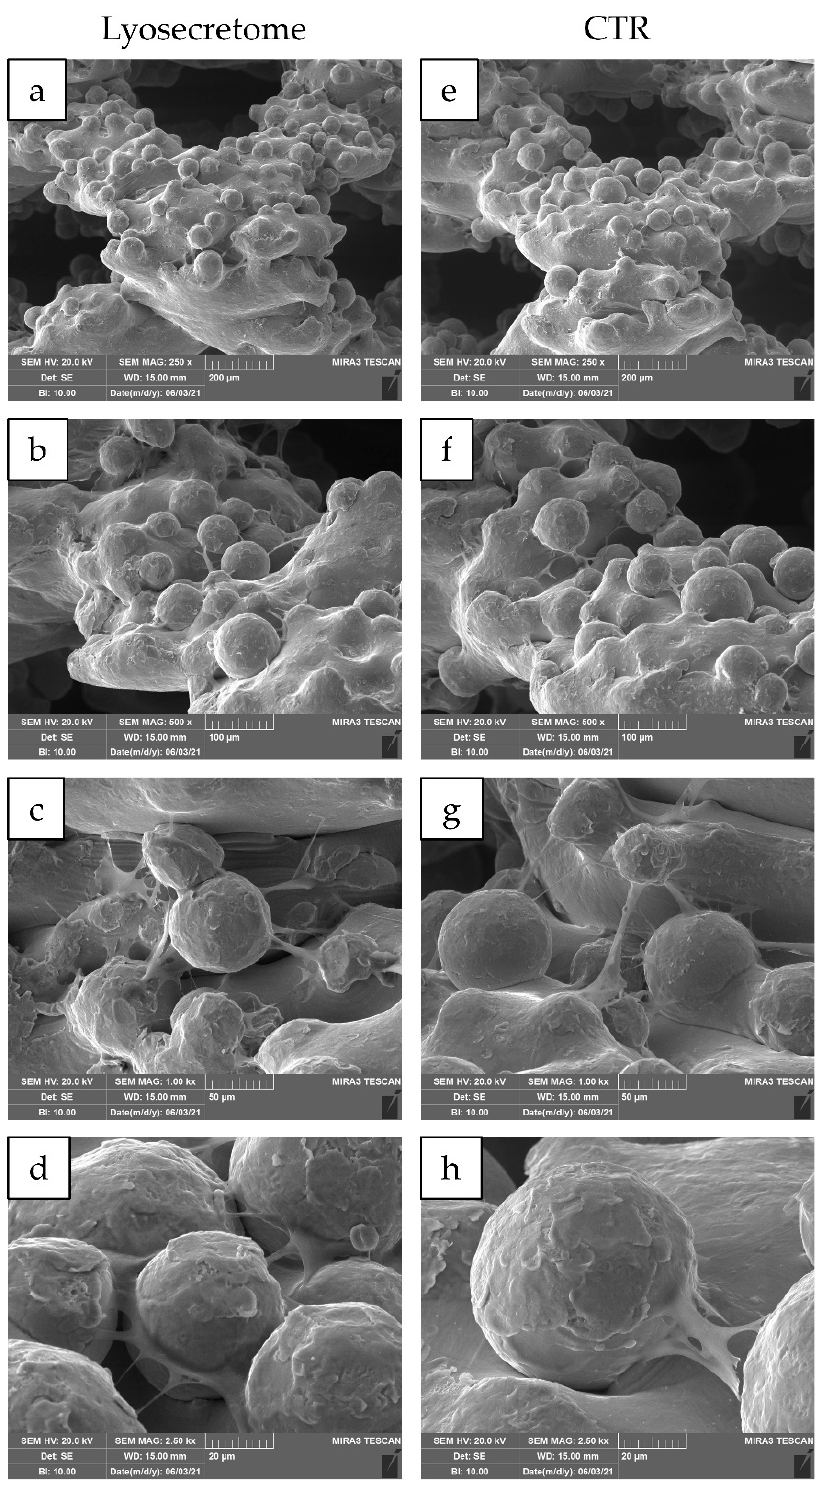
Figure 4. SEM morphological and structural characterizations of titanium cages seeded with MSCs and cultured in osteogenic medium with Lyosecretome or without (CTR) for 7 days. Magnifications: 250 × ( a , e ), 500 × ( b , f ), 1000 × ( c , g ), and 2500 × ( d , h ). Scale bars: 200 ( a , e ), 100 ( b , f ), 50 ( c , g ), and 20 ( d , h ) µm.